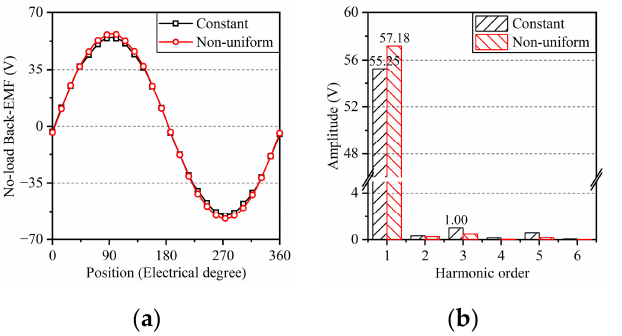
Figure 8. The no ‐ load back ‐ EMF ( a ) and harmonic order ( b ) of DCB ‐ VRLMs with different Figure 8. The no-load back-EMF ( a ) and harmonic order ( b ) of DCB-VRLMs with different combinations. combinations.